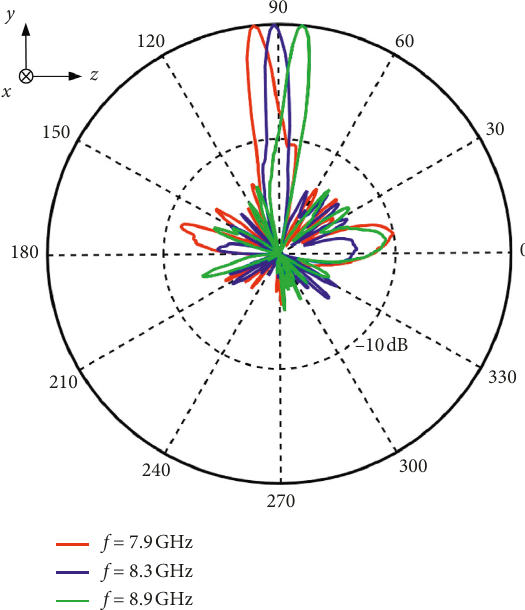
Figure 8: The measured radiation pattern of the proposed periodic antenna in the broadside direction.